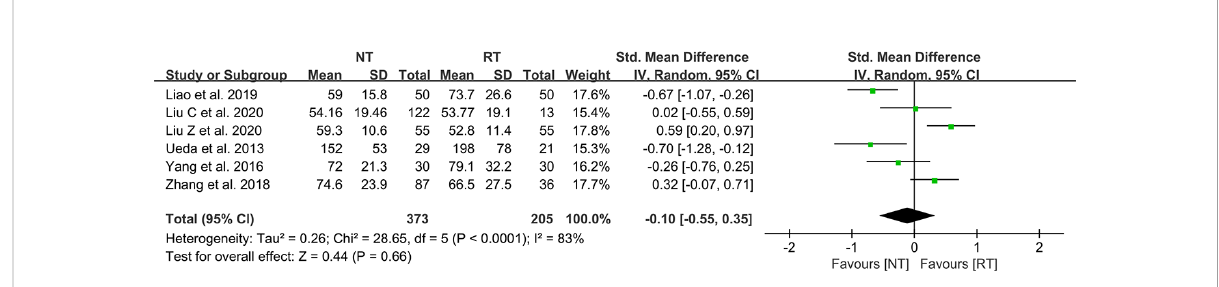
FIGURE 6 Meta-analysis of operation duration between the NT and RT groups. NT, no routine chest tube drainage; RT, routine chest tube drainage; CI, con fi dence interval.